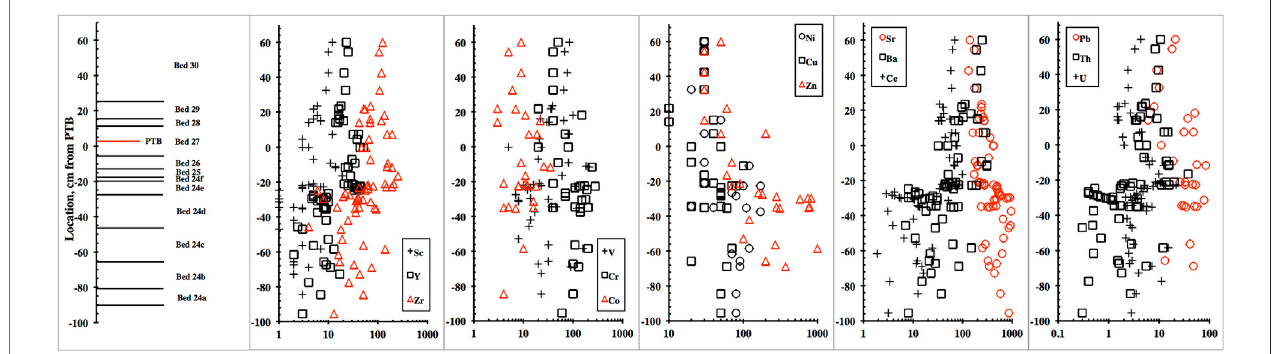
FIGURE 3 | Selected trace element data, plotted stratigraphically. All concentration data are on a log scale.